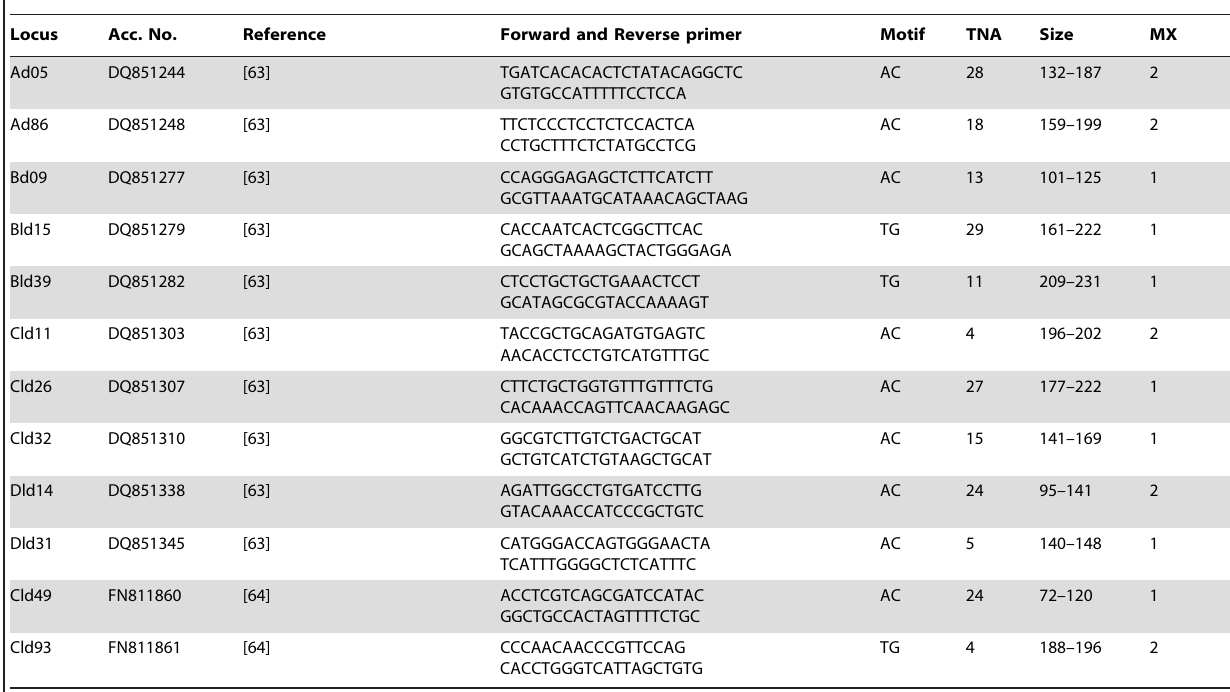
Table 2. Primers used in the genetic study of Diplodus sargus sargus .